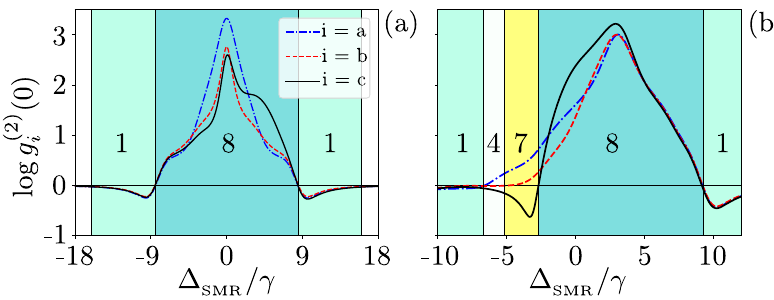
( 2 ) ( 0 ) versus the frequency detuning (cid:31) (in units of the qubit decay i SMR ω m ω q (so also (cid:31) (cid:31) m (cid:31) q ) SMR = SMR = = = ω m ω q , where ω b /γ 1560 MHz. Note that by changing the pump SMR = = = 7.5 γ and other =